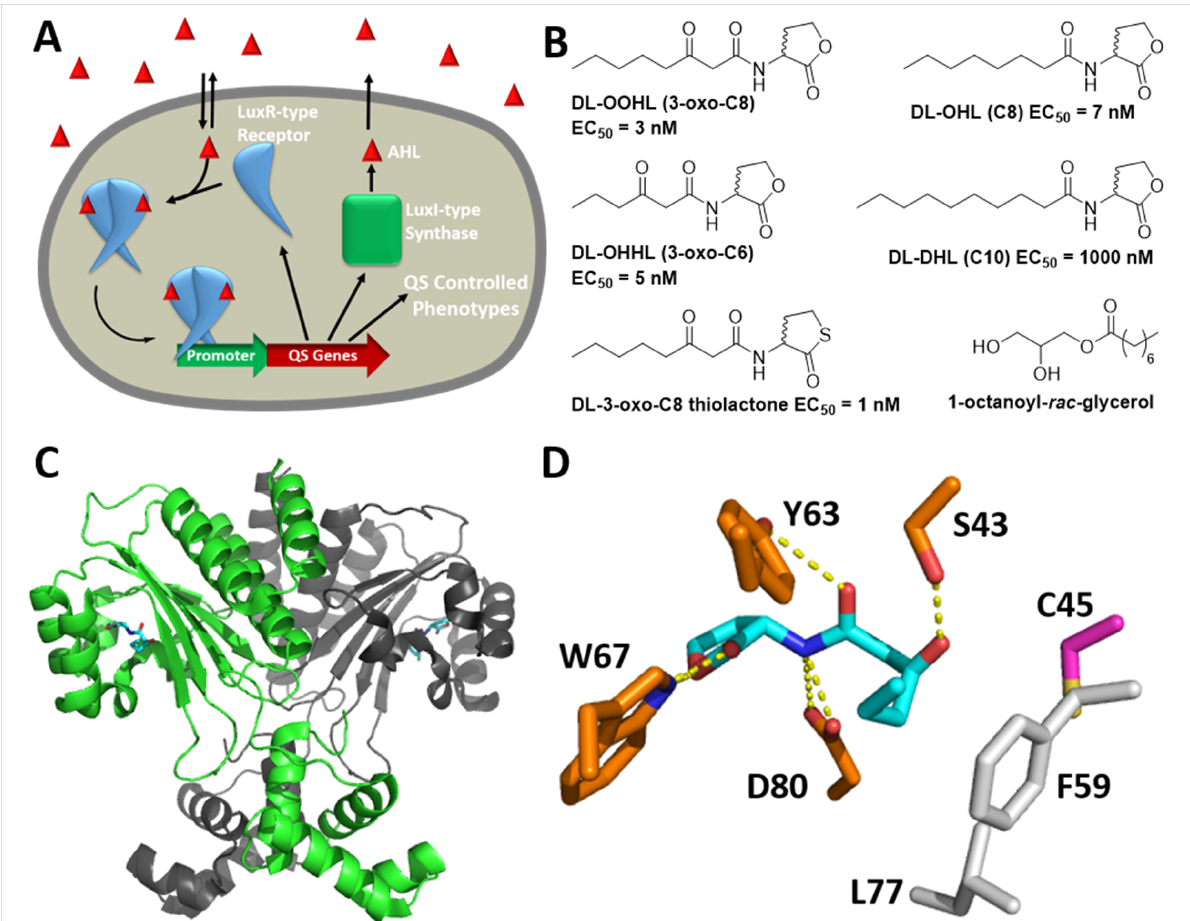
Figure 1: A) Overview of LuxI/LuxR-type QS. The LuxI-type protein produces the AHL signal. The AHL diffuses out of the cell and into the environ- ment and other neighboring cells. At high population density, the intracellular concentration of AHL is sufficiently high to productively bind to the LuxR- type receptor protein. AHL binding typically promotes receptor homodimerization and binding to DNA at various promoters to activate transcription of QS-controlled genes, often including luxI and luxR (thereby autoinducing the QS system). B) Compounds previously reported to modulate SdiA (all examined as racemates) [20]. Their reported EC 50 values in a S. Typhimurium SdiA reporter system are shown. L-OOHL (3-oxo-C8), L-OHHL (3-oxo- C6), L-OHL (C8), L-DHL (C10), and 1-octanoyl- rac -glycerol have been crystalized with SdiA from enterohemorrhagic E. coli (EHEC) [21,22]. C) The solid-state structure of the SdiA homodimer (PDB 4Y15; monomers shown in green and grey) bound to OOHL (cyan) [22]. D) Selected residues sur- rounding OOHL (cyan) in the SdiA ligand binding pocket (from PDB 4Y15 [22]): hydrogen bond acceptors/donors (orange), hydrophobic residues (grey), and a cysteine that potentially could be involved in inhibition (purple, see discussion